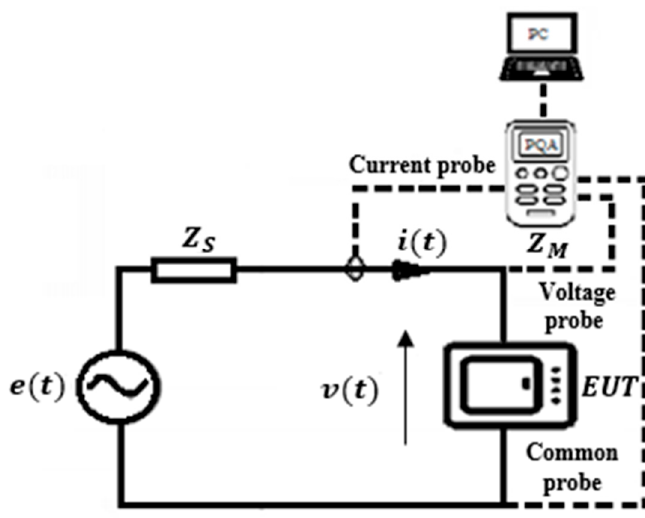
Figure 4. Diagram of the measurement system.